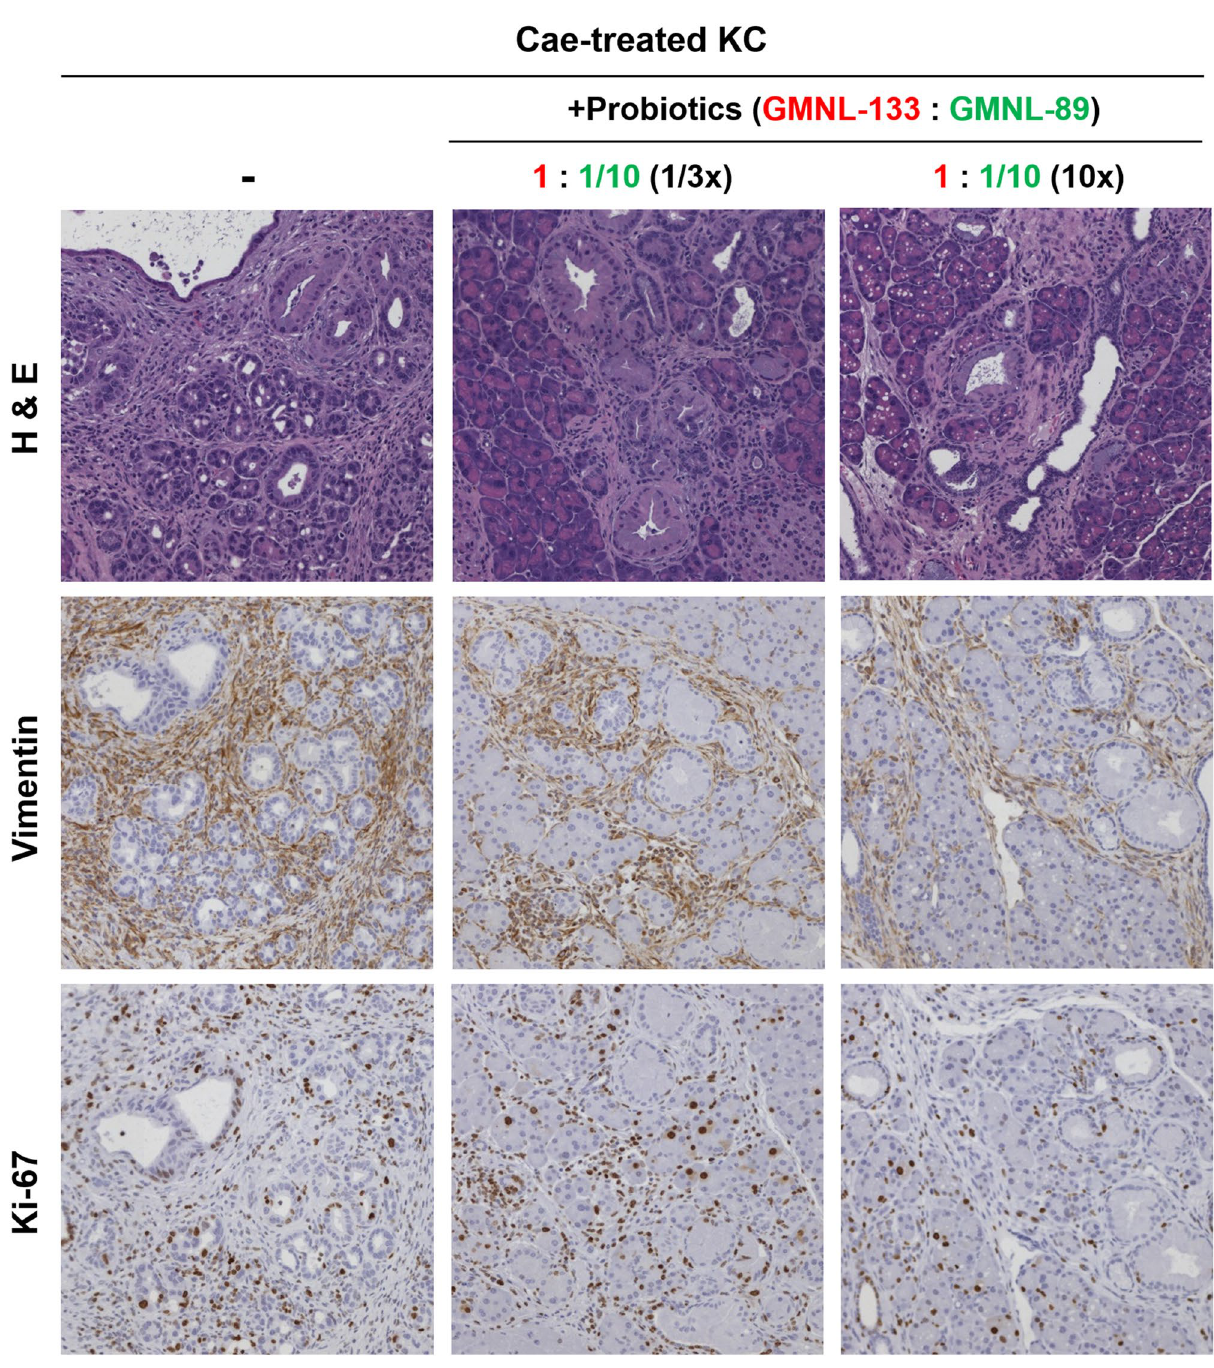
GMNL133: GMNL89 = 1:1/10, 10x). The group receiving 10 × higher probiotic doses showed a lower grade of PanIN progression in H&E staining and a lower expression of vimentin and Ki-67 staining. Cae, caerulein; H&E, Hematoxylin and eosin; KC , LSL-Kras G12D/- ; PDX-1-Cre transgenic mice; PanIN, pancreatic intraepithelial